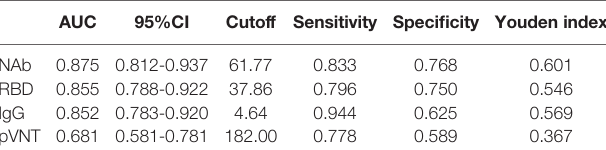
TABLE 2 | Optimal cut-off values.